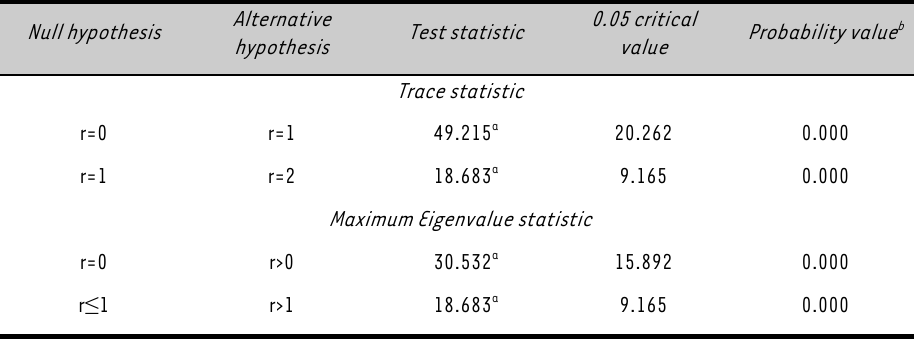
TABLE 2: Cointegration test results Null